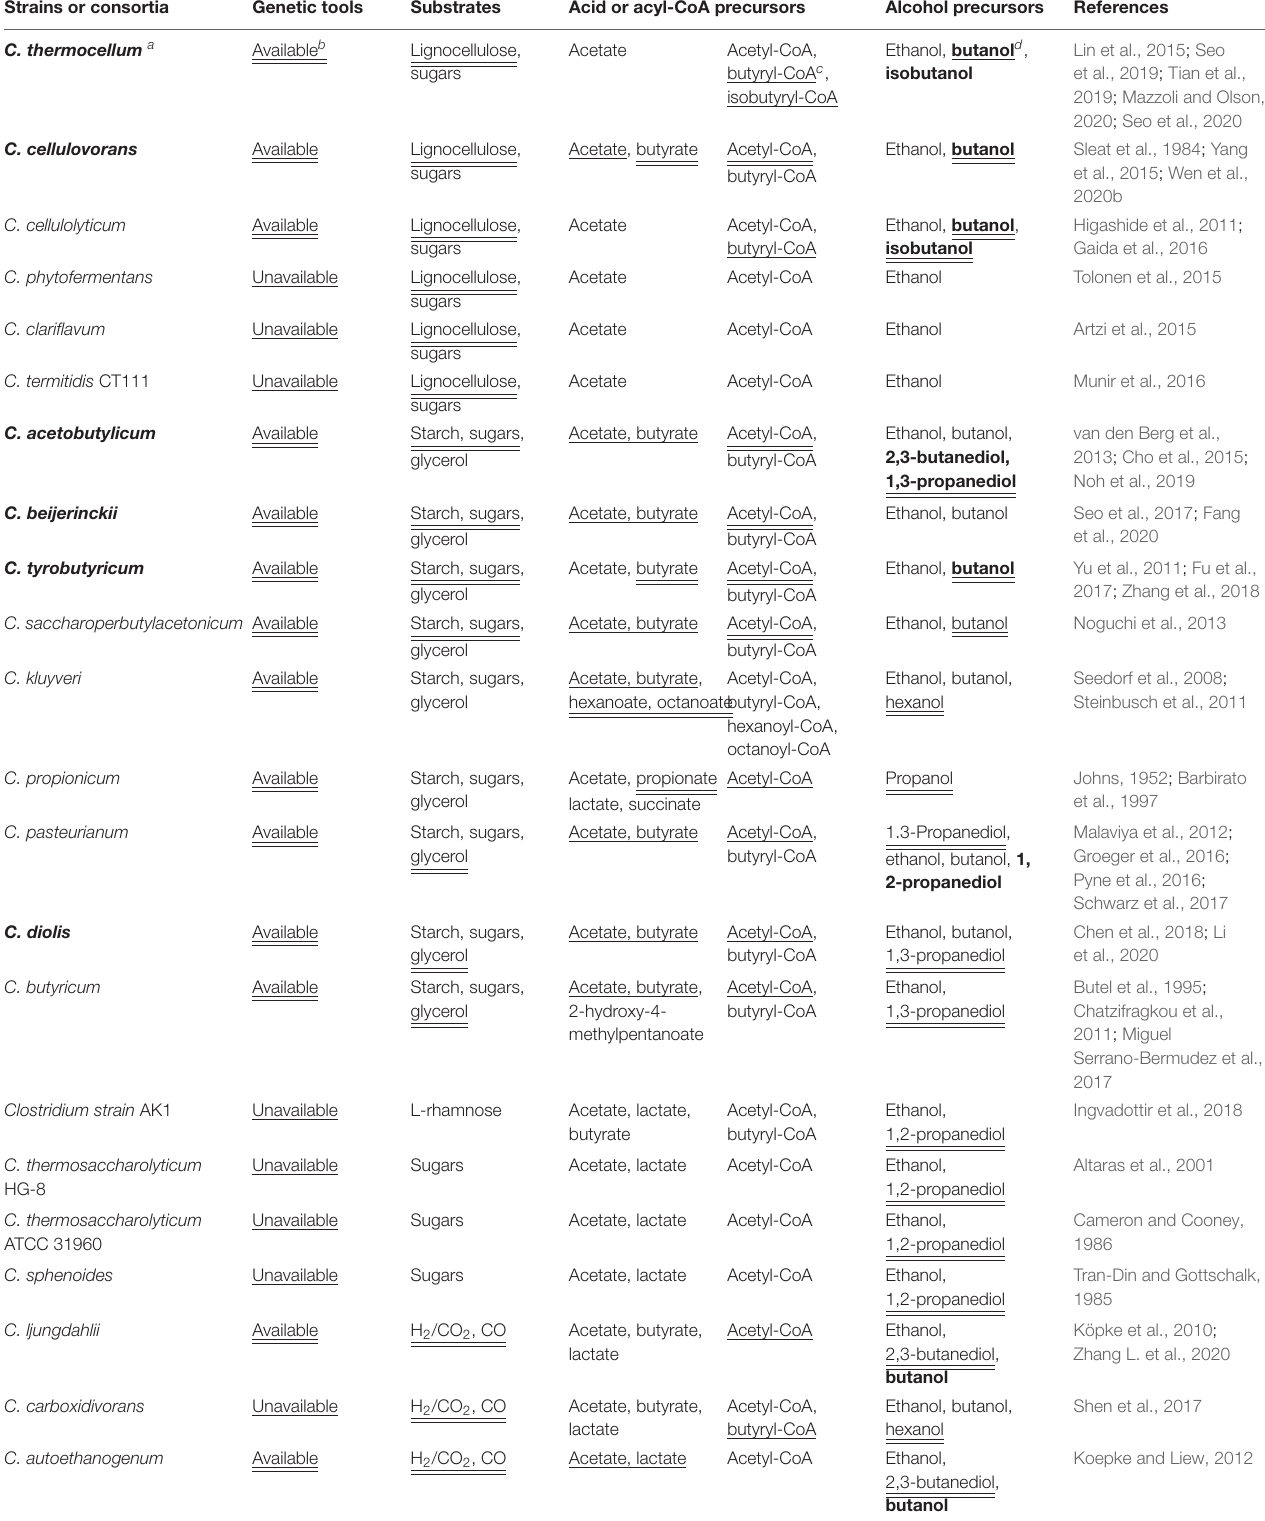
TABLE 1 | Potential Clostridia for the production of short- and medium-chain